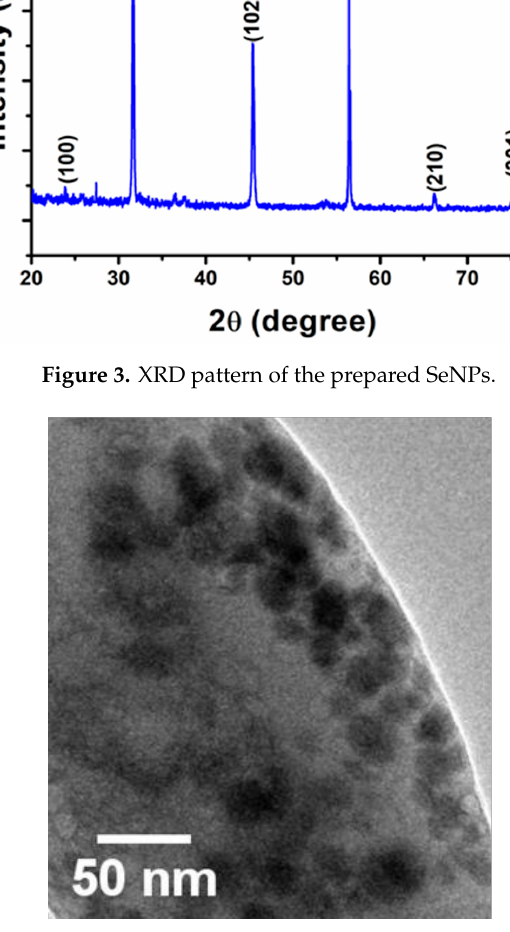
Figure 4. TEM image of the prepared SeNPs.